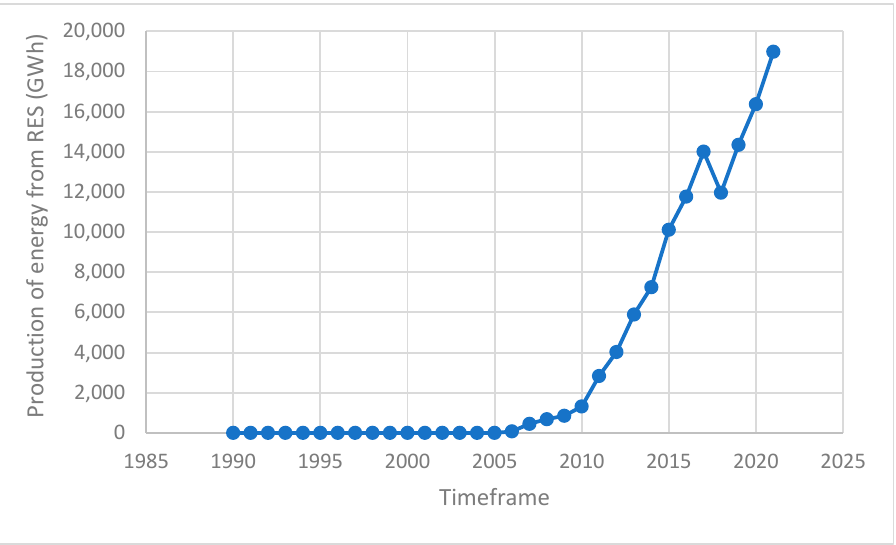
Figure 5. Domestic production of electricity from renewable sources between 1990 and 2021. Source: